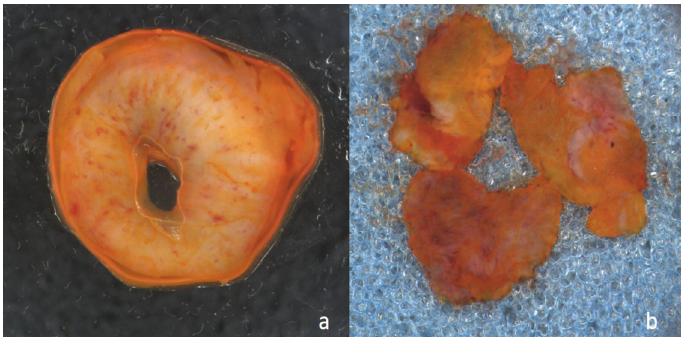
Figure 1. Macroscopic image of resection margin prepared with acridine orange for Vivascope analysis: ( a ) from a ureter, and ( b ) from the urethra.